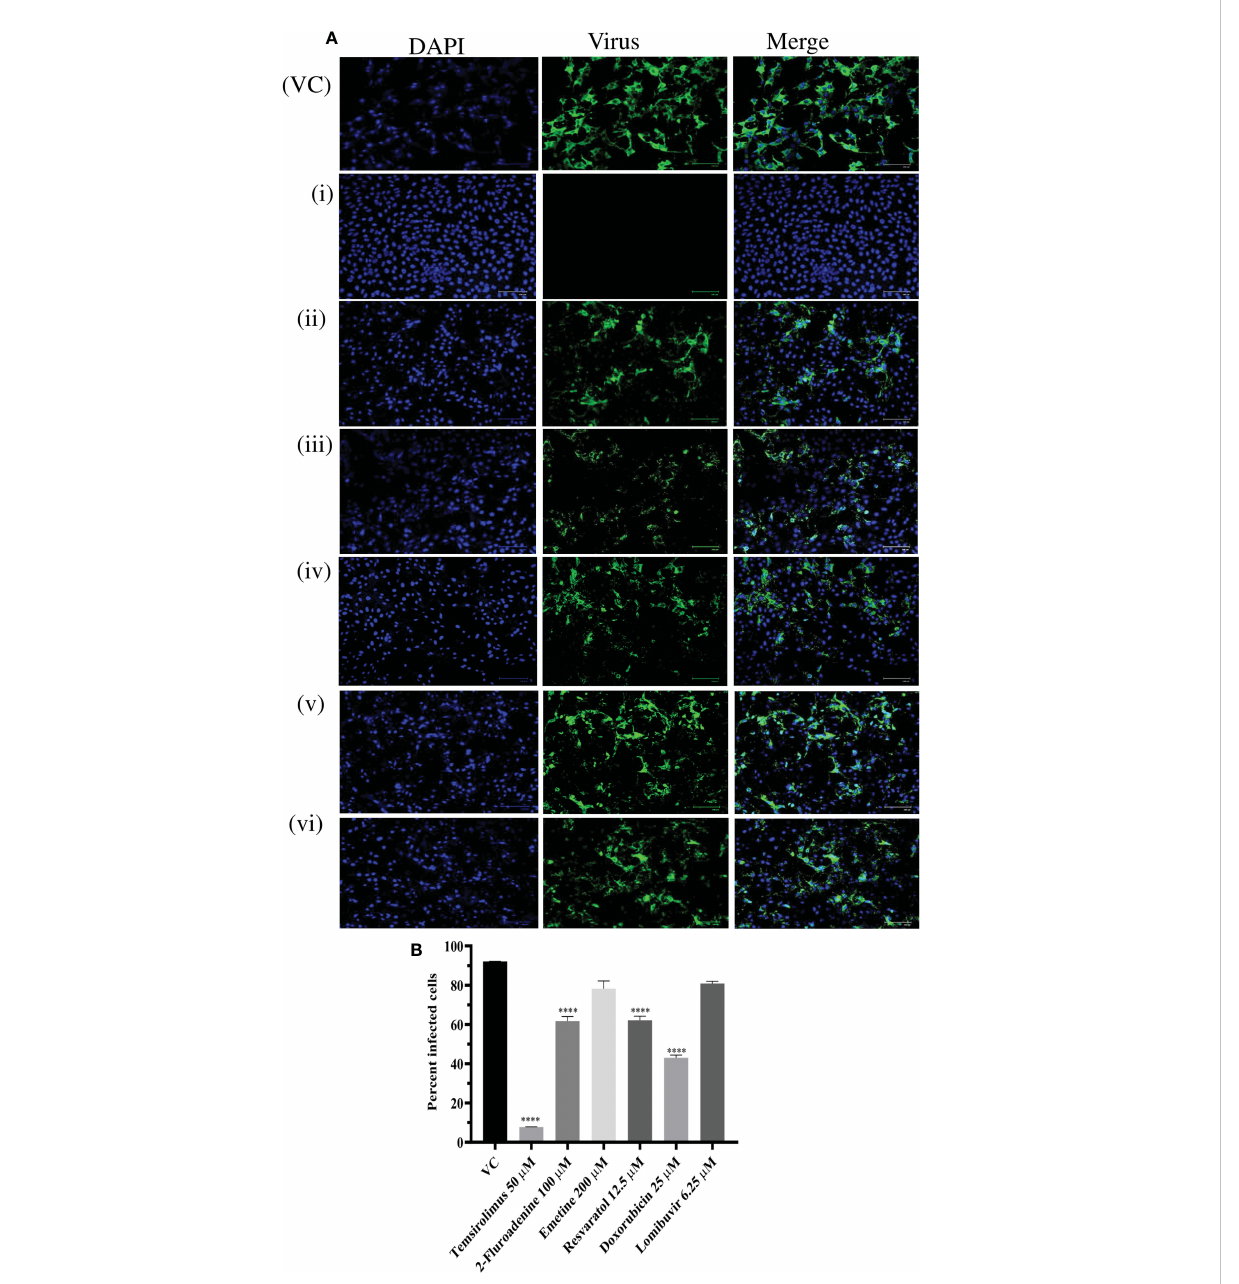
FIGURE 6 Effect of different drugs i.e. Temsirolimus (i), 2- fl uoroadenine (ii), emetine (iii) resveratol (iv) doxorubicin (v), lomibuvir (vi) on CHIKV infection under posttreatment condition using IFA. Images represent CHIKV infected Vero CCL-81 cell lines under posttreatment condition. Cells infected with virus appear green in colour (A) Percentage of infected Vero CCL-81 cells in cultures treated with different concentrations of drug under posttreatment condition (B) All the treatment conditions were compared with the virus control. ****p < 0.0001. VC, virus control; CC, cell control: DC, drug